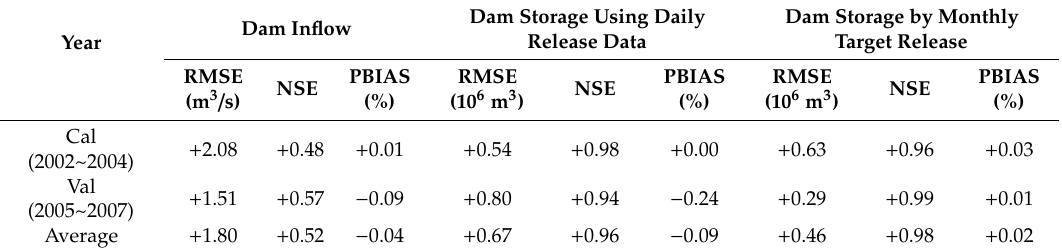
Table 3. The statistical summary of SWAT calibration and validation for dam inflow and